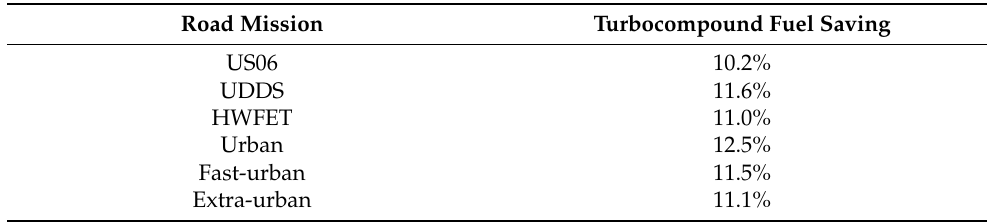
Table 16. Turbocompound fuel